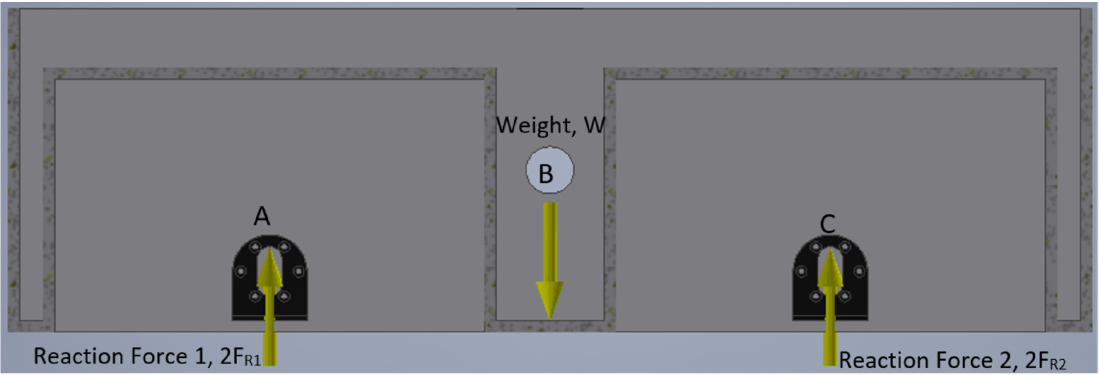
Figure 12. Free-body diagram of the lawnmower. Note: F R1 = F R2 .